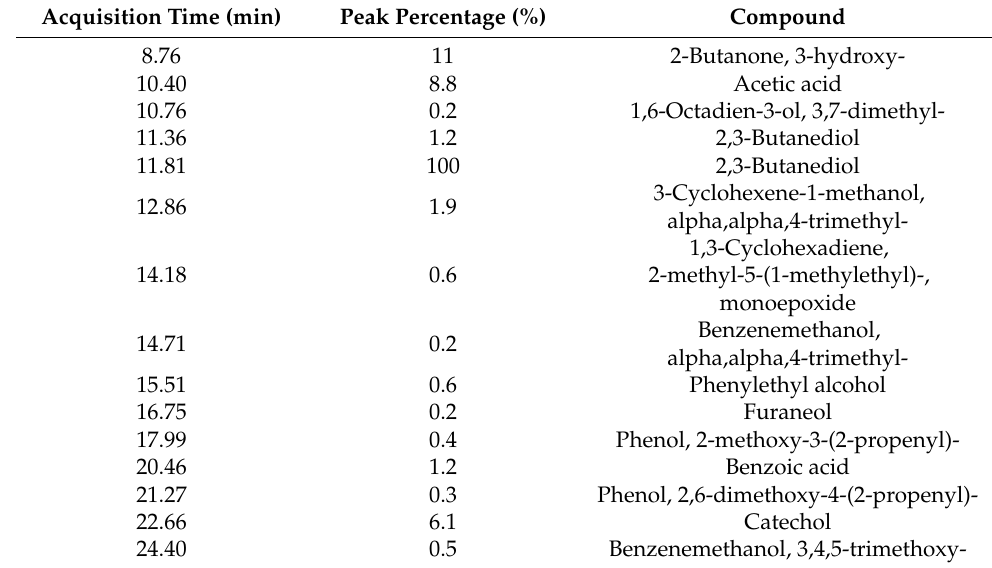
Figure 3. GC/MS analysis of Callistemon viminalis . Table 1. Peak percentage having more than 90% match with chemical compounds.